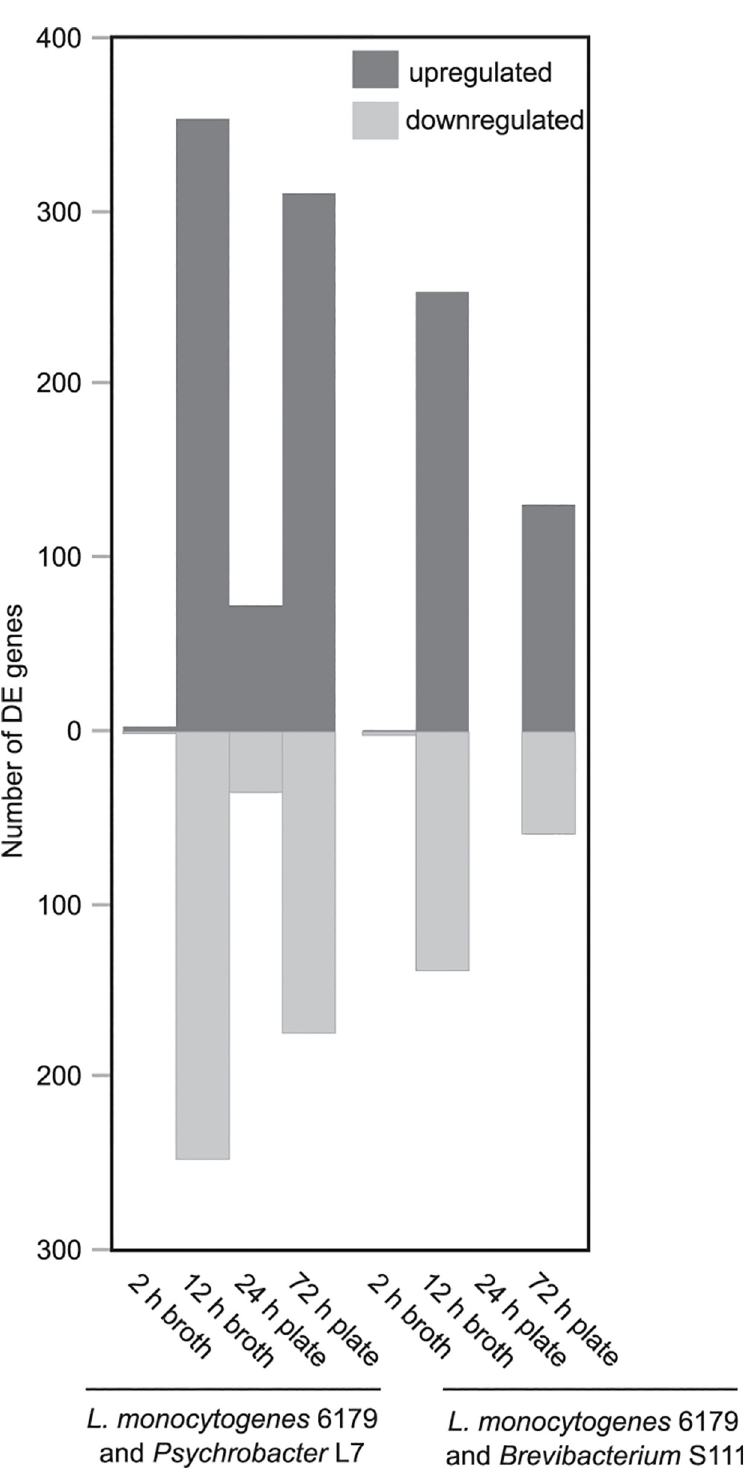
Fig 1. The number of L . monocytogenes 6179 DE genes after co-cultivation with either Psychrobacter L7 or Brevibacterium S111. Genes were considered differentially expressed if q < 0.05.